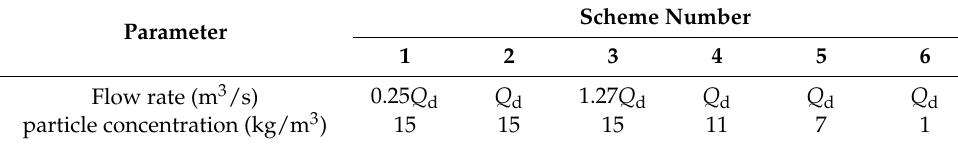
Scheme Number 1 2